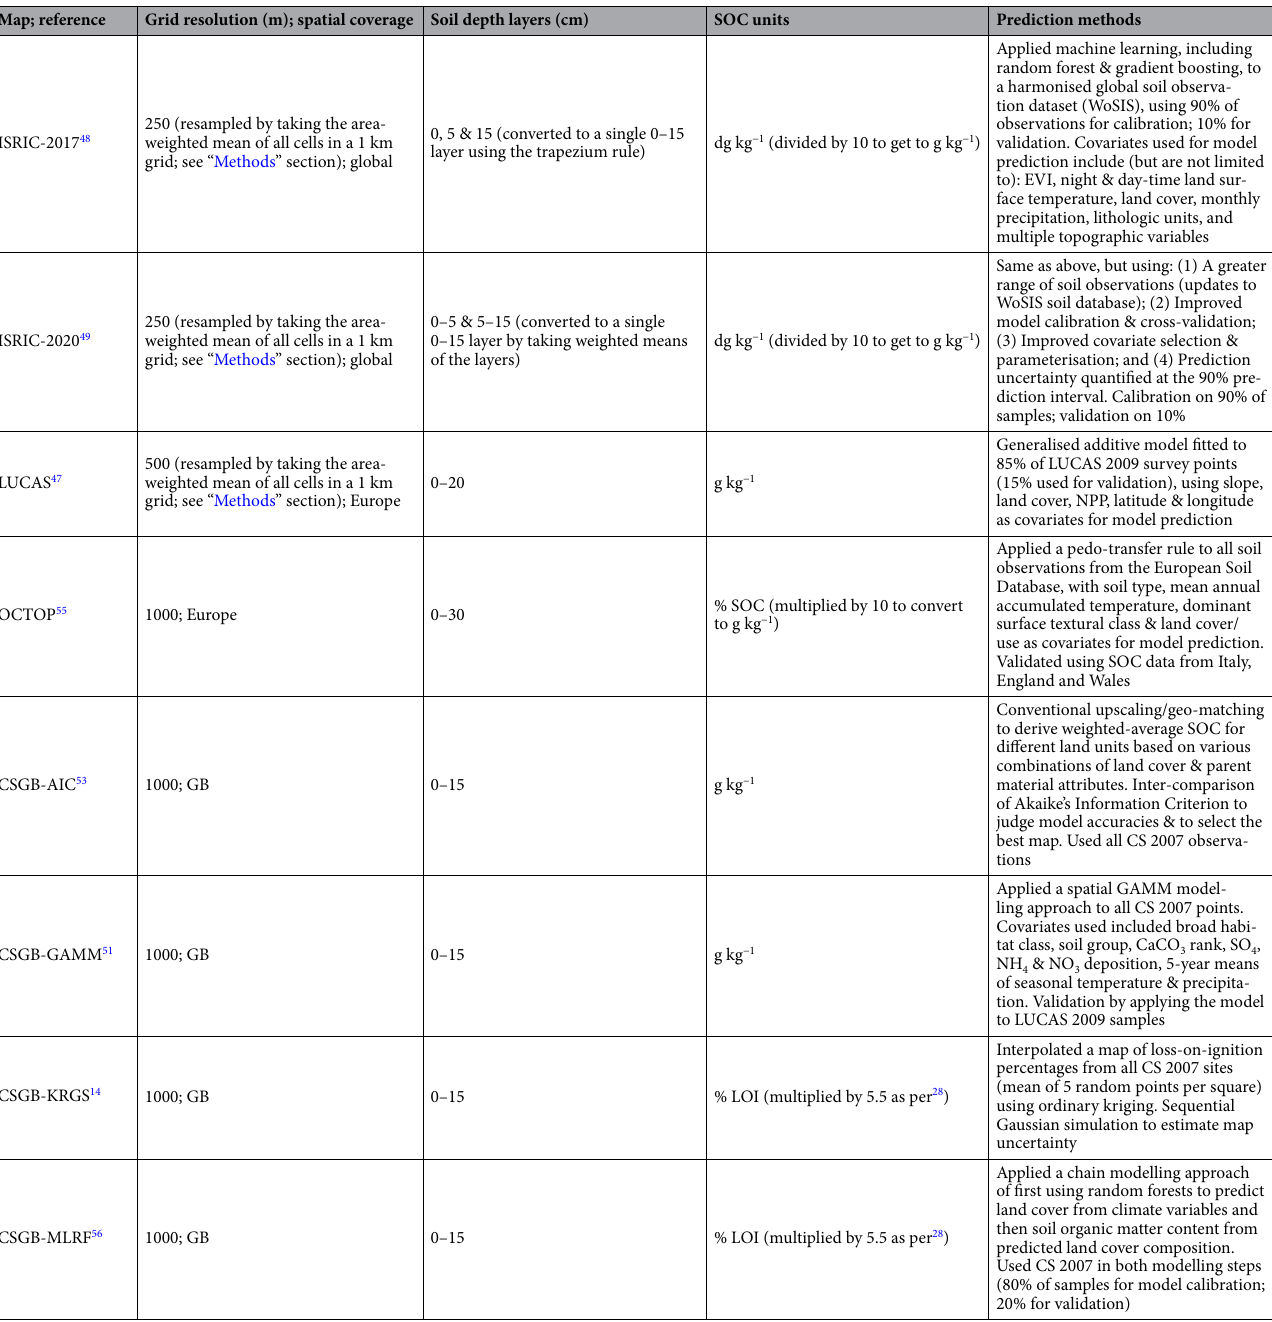
Table 1. Summaries of each of the eight topsoil SOC concentration